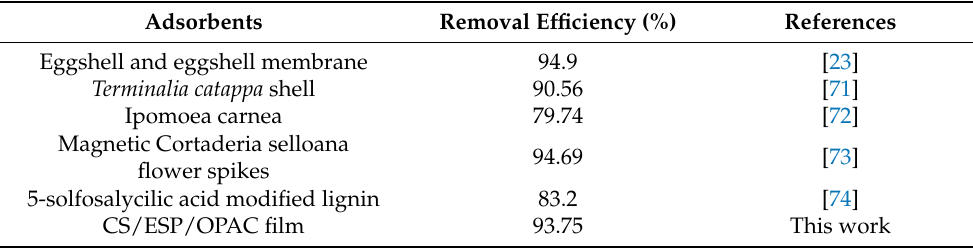
Table 3. The comparison of removal efficiency of various biosorbents for methylene blue.